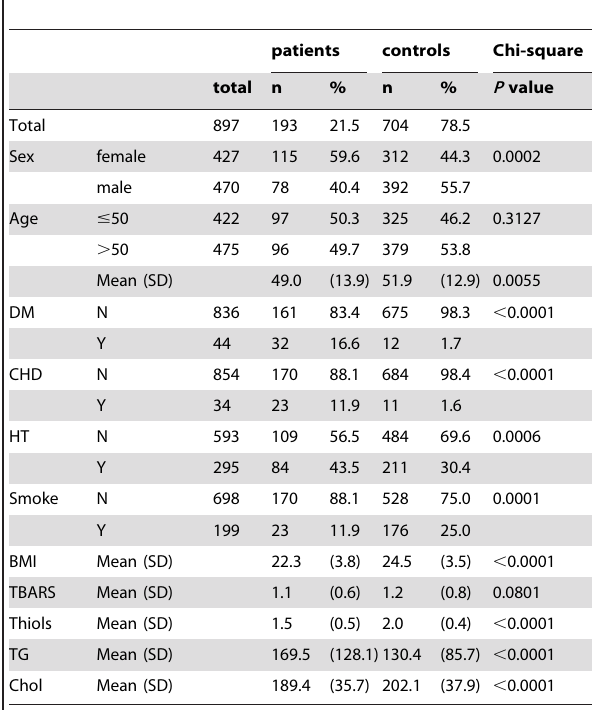
Table 1. Basic demographic characteristics of patients and